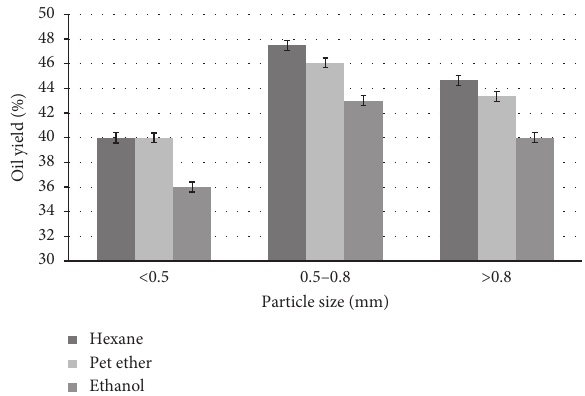
Figure 5: Effect of particle size on oil